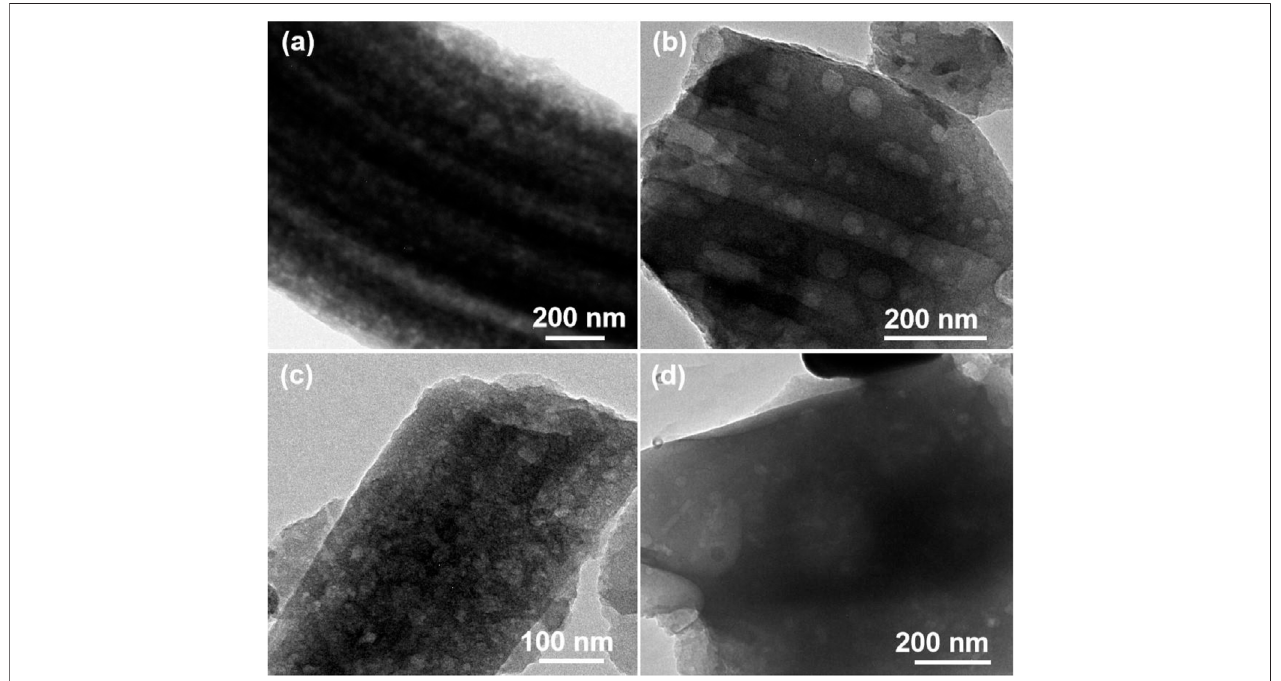
FIGURE 6 | TEM images of (A) 2FeS2@CNFs, (B) 3FeS2@CNFs, (C) 4FeS2@CNFs, and (D) 5FeS2@CNFs.